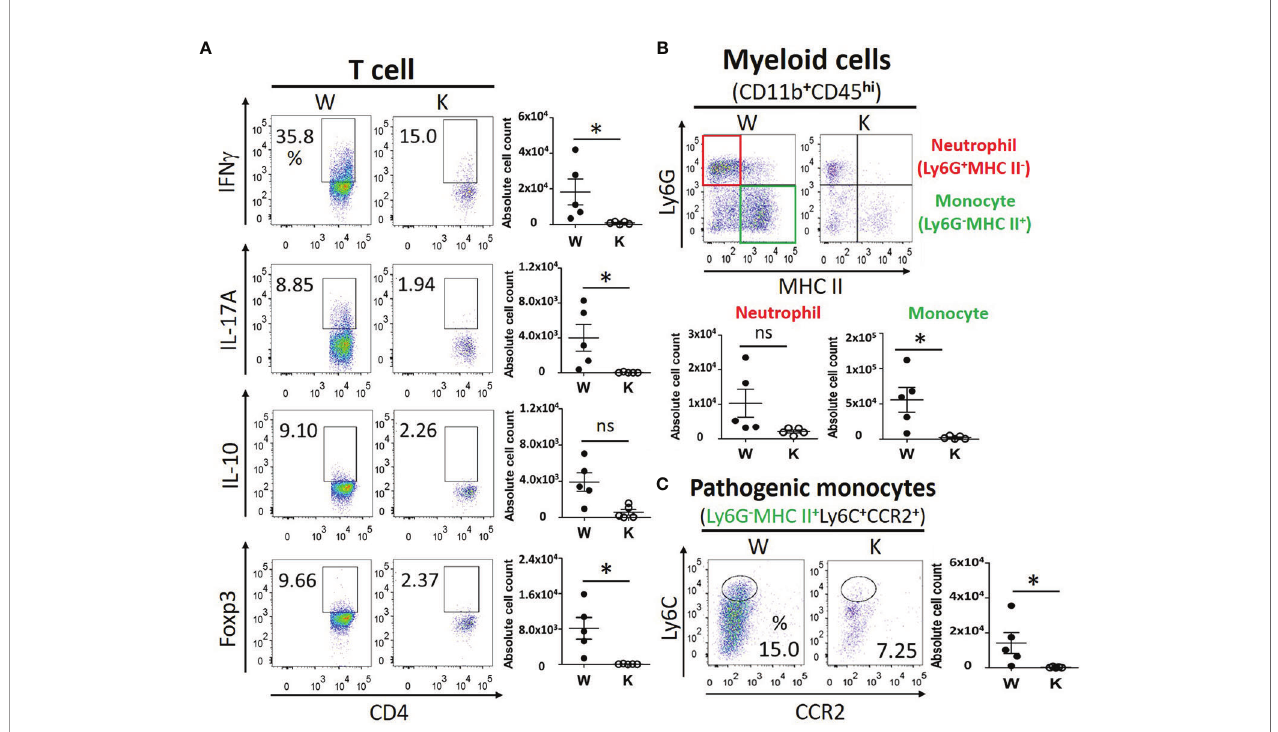
FIGURE 4 | Nox2 de fi ciency greatly reduces the EAE-elicited invasion of pathogenic immune cells into the CNS on disease peak (17 dpi). (A) the T cell pro fi les of IFN g (T H 1), IL-17A (T H 17), IL-10, and Foxp3 (Treg)-producing cells from CNS mononuclear cells between W and K groups (n = 5 each group). (B) the myeloid cell pro fi les (CD11b + CD45 hi ) of neutrophils (Ly6G + MHC II − ), monocytes (Ly6G − MHC II + ), and (C) the absolute cell counts of pathogenic monocytes (Ly6G − MHCII + Ly6C + CCR2 + ) from CNS mononuclear cells between W and K groups (n = 5 each group). p value: * < 0.05; ns, not signi fi